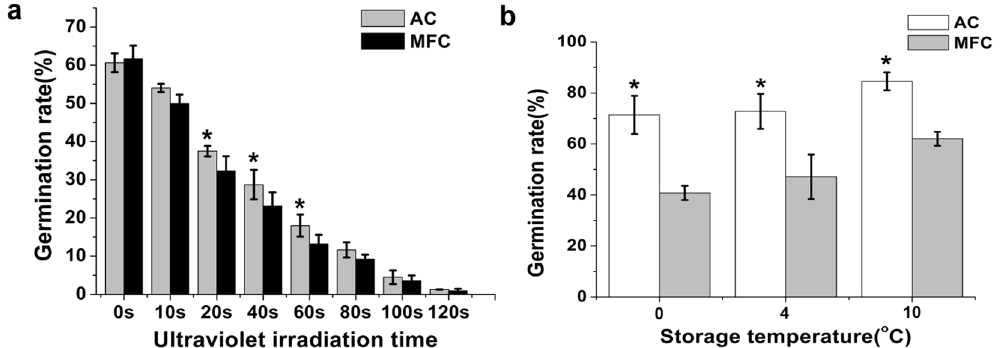
Figure 4. UV tolerance and cold stress test. ( a ) Bar graph quantifying conidial germination exposed AC and MFC of Hirsutella satumaensis to UV radiation for different duration range 0 s to 120 s. UV irradiation slowed the growth of both types of spores, but AC was less affected. Conidial germination was significantly different between AC and MFC ( p < 0.05) following UV irradiation for 20 s (37.46 ± 1.372% vs. 32.26 ± 3.862%, respectively), 40 s (28.71 ± 3.831% vs. 23.13 ± 3.592%) or 60 s (17.97 ± 2.881% vs. 13.17 ± 2.380%). ( b ) Testing the spore viabilities of AC and MFC under cold stress (0 °C, 4 °C and 10 °C). Germination rate of MFC decrease significantly, especially at 0 °C. Statistical analysis was performed using a one-way ANOVA. Error bars are standard deviations of three trials and panels are representative of at least 2 independent experiments, * p <